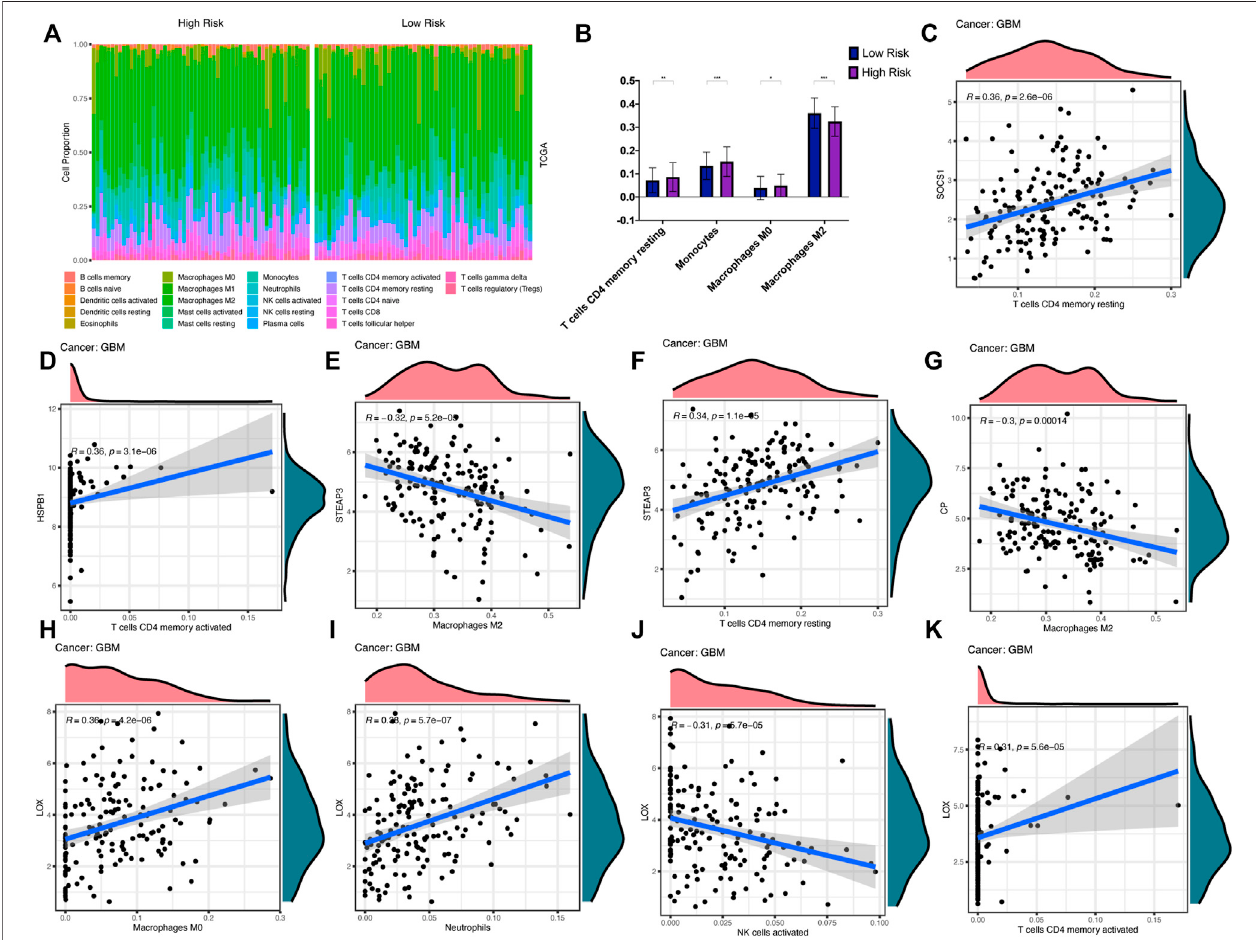
FIGURE 9 | Immune cell in fi ltration analysis (A,B) In fi ltration differences of 22 immune cells in high- and low-risk groups in TCGA-GBM (C – K) Correlation curves show that in fi ltration levels of six immune cells are signi fi cantly correlated with key genes expression levels.